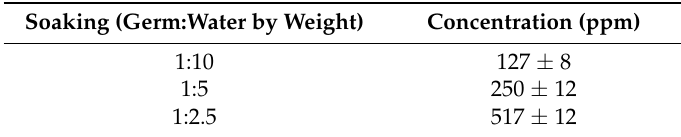
Table 1. Free amino nitrogen (FAN) concentrations in the water obtained from germ soaked under various conditions.